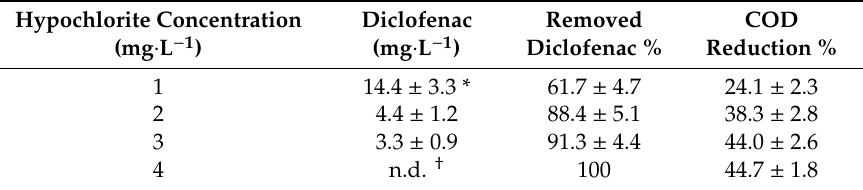
Table 4. Treatment with sodium hypochlorite (contact time 2 h).